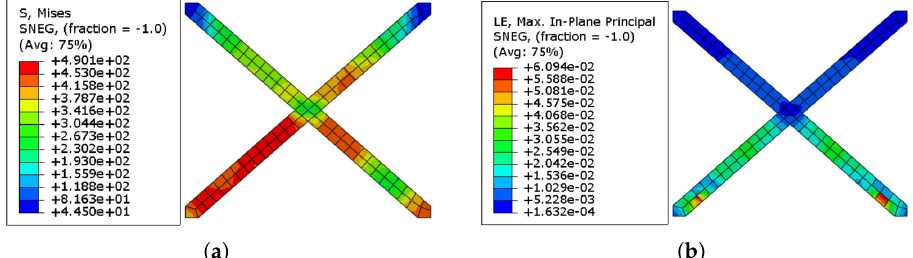
Figure 24. ( a ) Stress distribution in the Ni–Ti Strips used in the URM-SMA-ECC system; ( b ) Strain distribution in the Ni–Ti Strips used in the URM-SMA-ECC system.